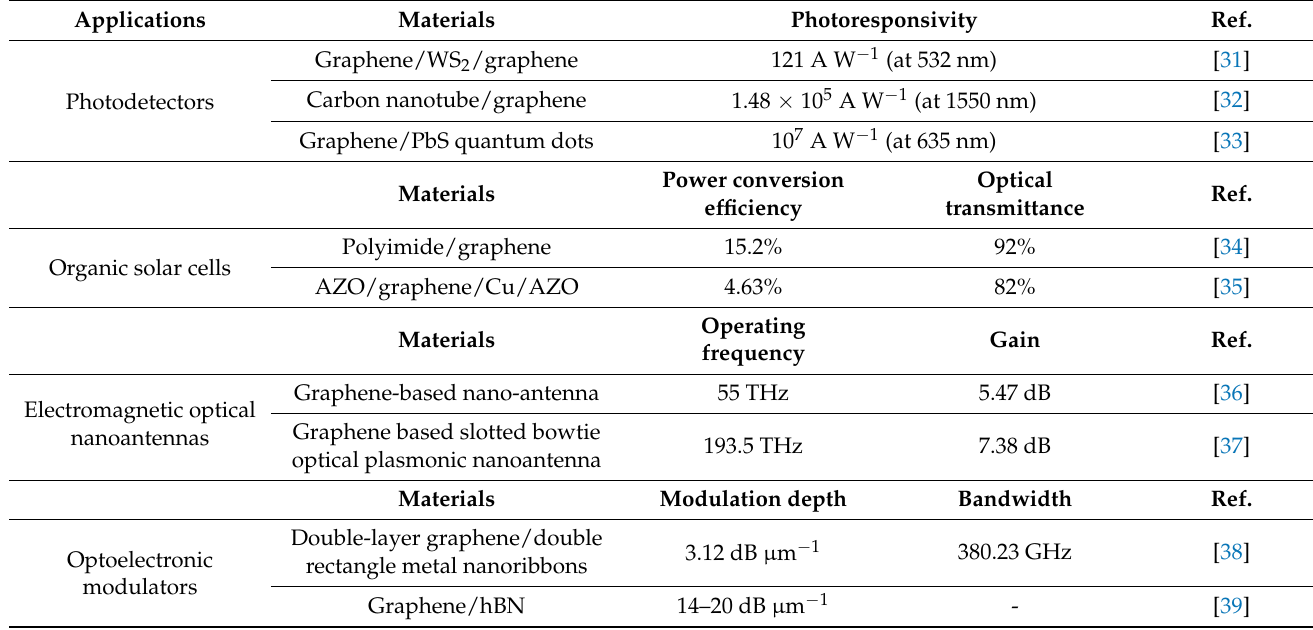
Table 1. Optoelectronic applications based on